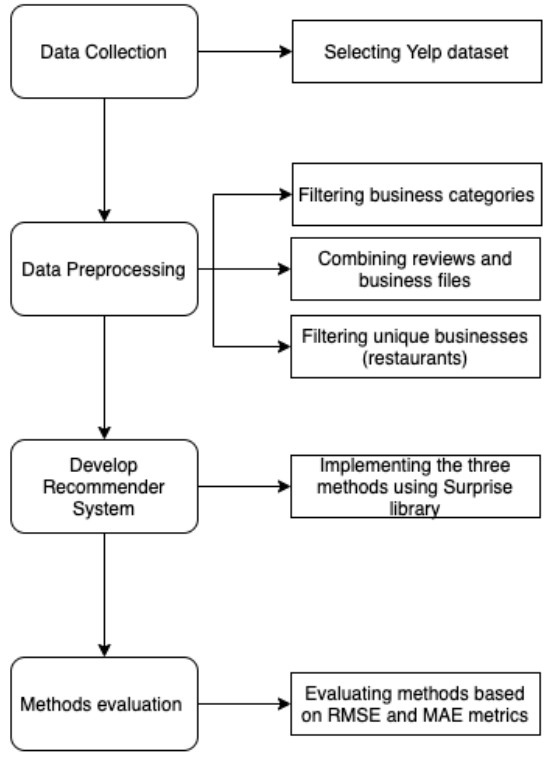
Figure 1. Steps performed to analyze the recommendation methods.